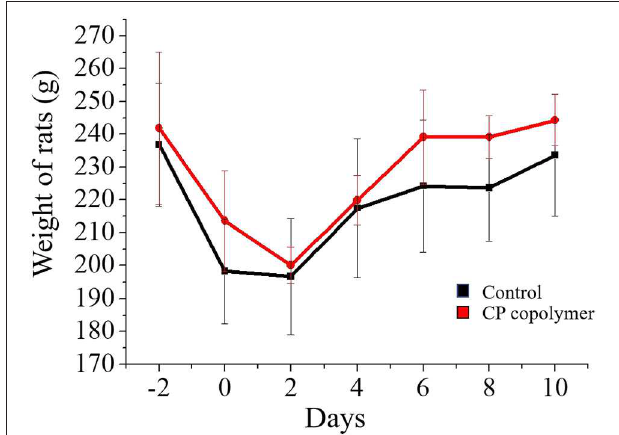
FIGURE 6 | Weight curve of Wistar rats treated with CP copolymer compared to the case for PBS treatment (in the control group).